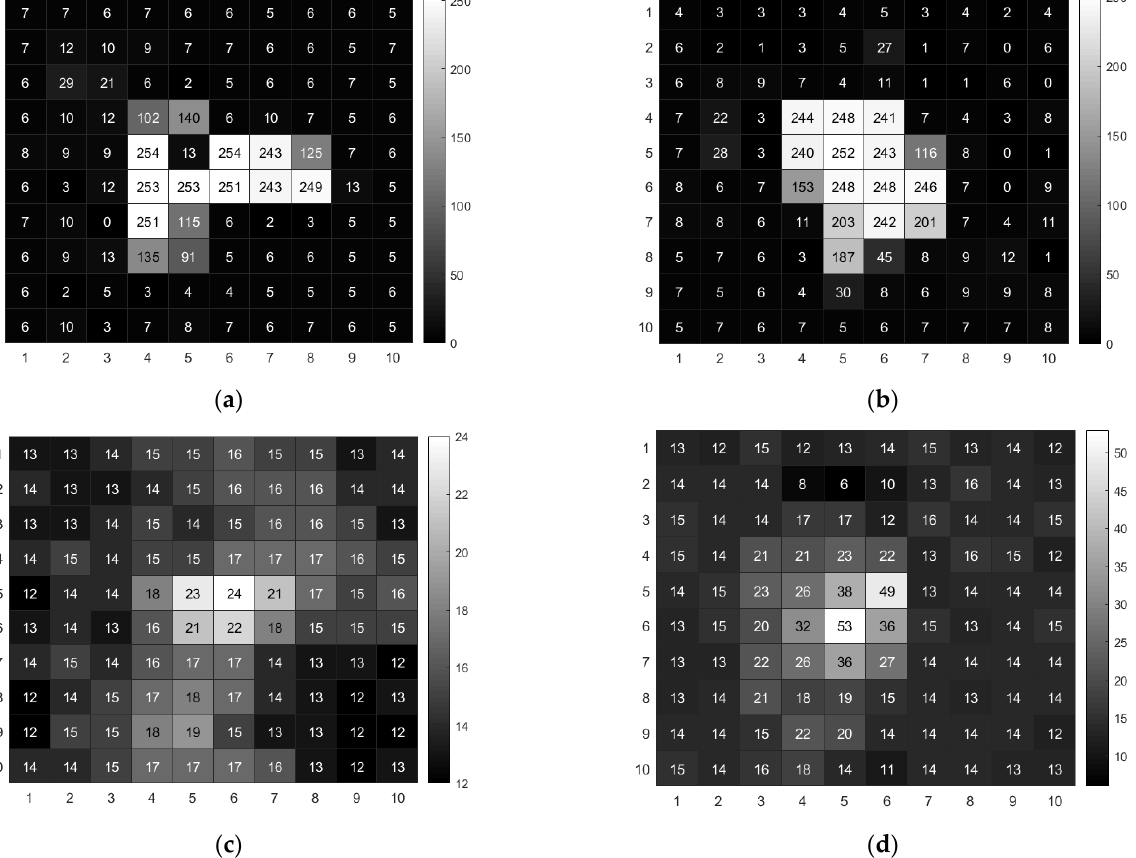
Figure 2. Heatmap of radiation event in a sensor frame. ( a ) 60 Co γ source radiation Event. ( b ) 137 Cs γ source radiation event. ( c ) Am-Be source radiation event. ( d ) 252 Cf source radiation event.